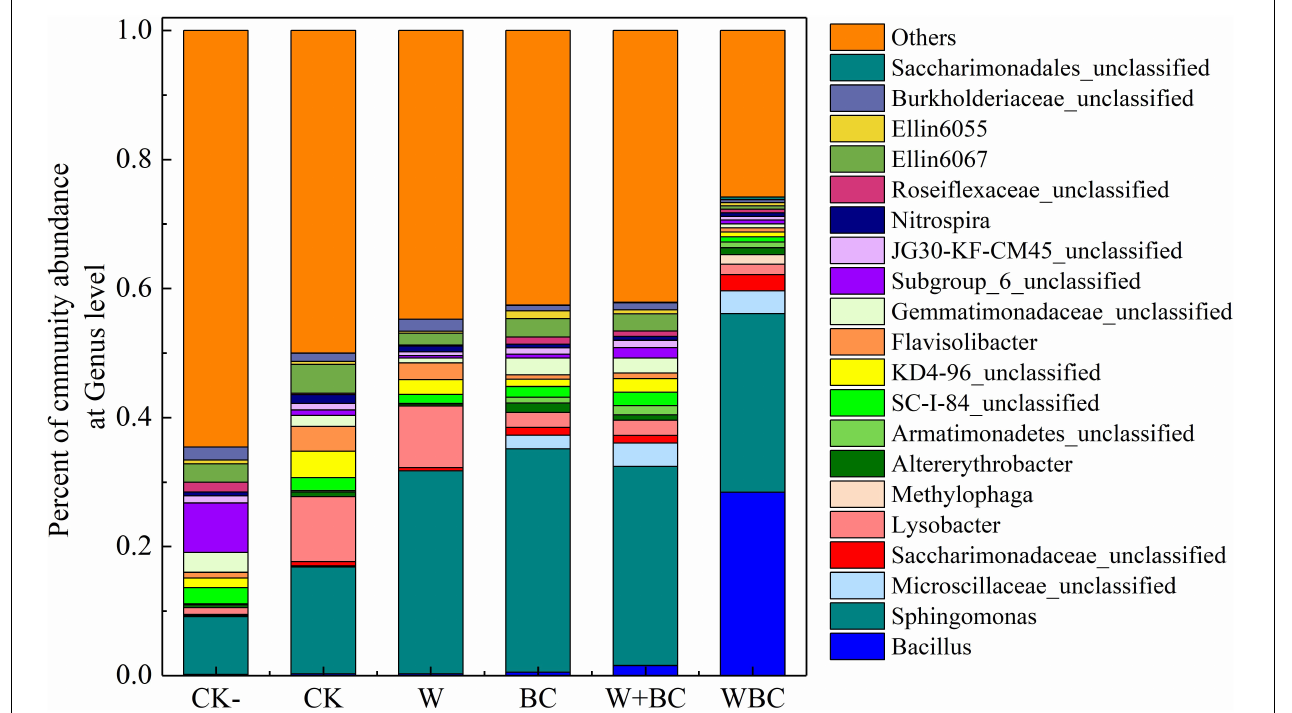
Frontiers in Microbiology |